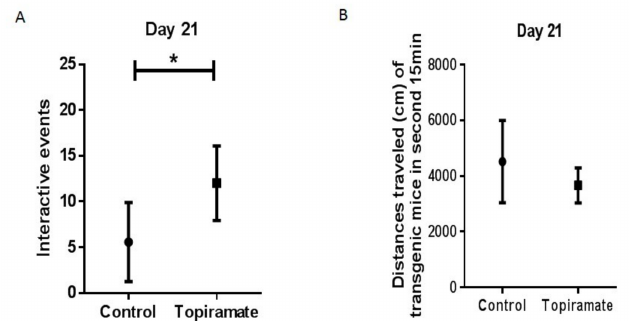
Figure 2. Effect of topiramate treatment on behavioral impairments (social interaction assay). APP / PS1